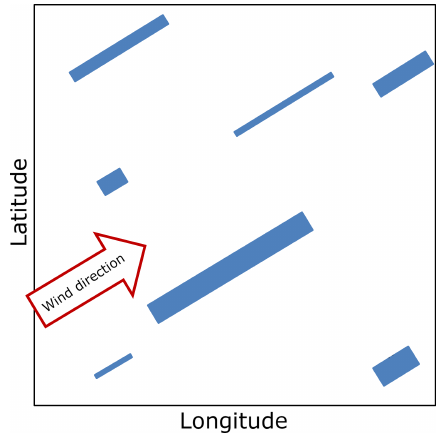
Figure 5. Schematic of embedded convection implementation by using rectangular cells (blue). The orientation is defined by the wind direction (arrow); each cell is assigned to an individual factor c conv